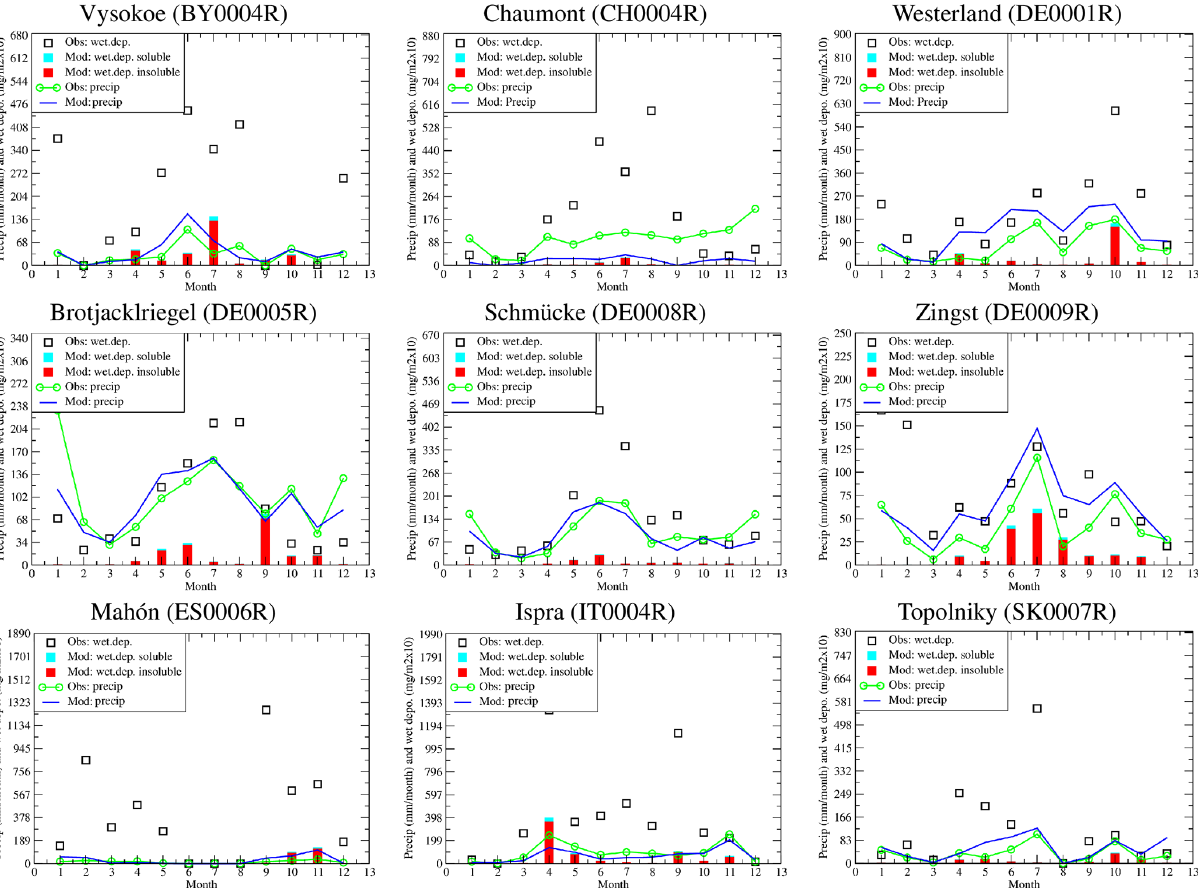
Figure 8. Time series of monthly precipitation rates (millimetres per month) and nssCa 2 + wet-deposition fluxes (mg ( m − 2 ) 10). The bars represent the monthly deposition fluxes of Ca 2 + : soluble in blue and insoluble in red. The blue line represents the simulated monthly cumulated precipitations. The measurements are represented with symbols. Results are presented for the whole year of 2012 and observations are accumulated monthly from weekly